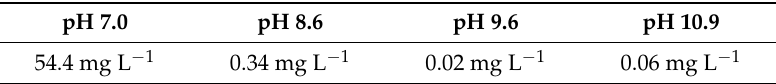
Table 1. Dissolved zinc concentrations at different pH values (start: 50 mg L − 1 ).